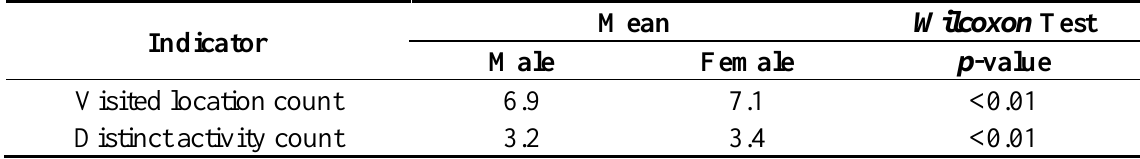
Table 5. Average visited location count and distinct activity count values for the selected male and female survey participants and results of the Wilcoxon